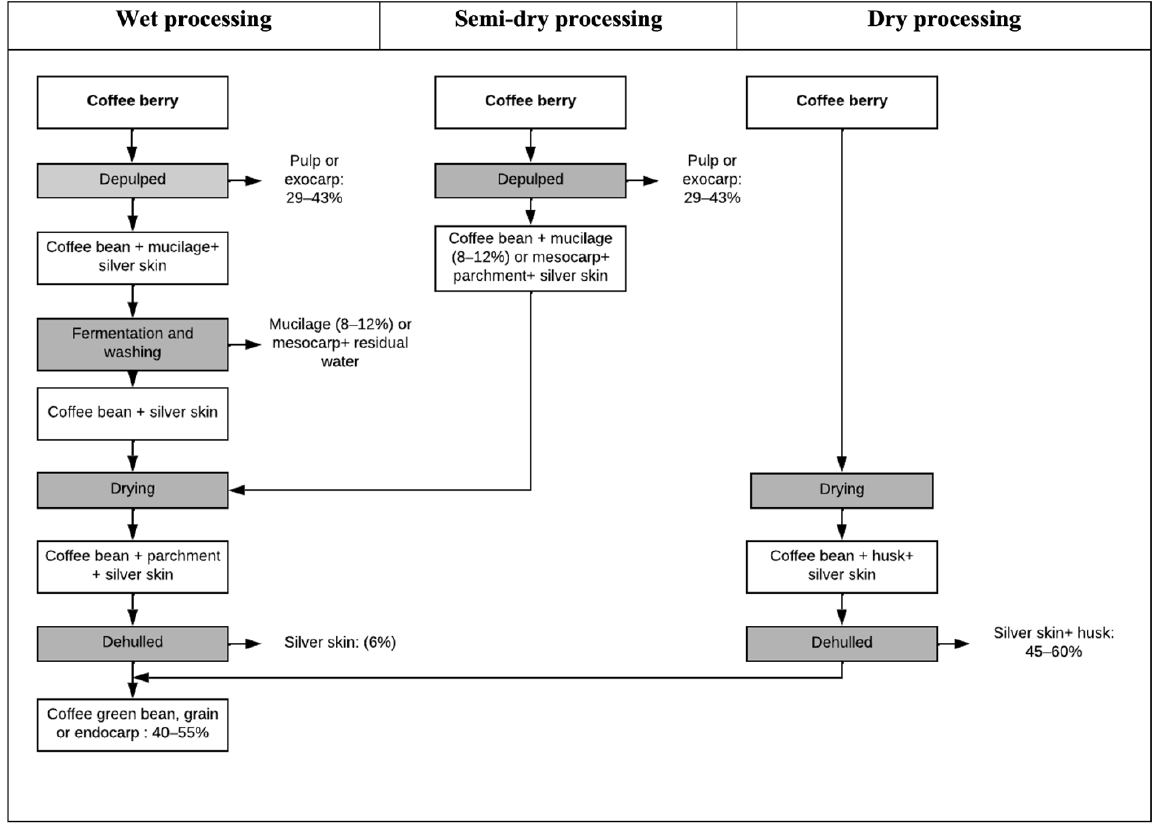
Figure 3. Manufacturing processes of coffee bean [11 – 14].